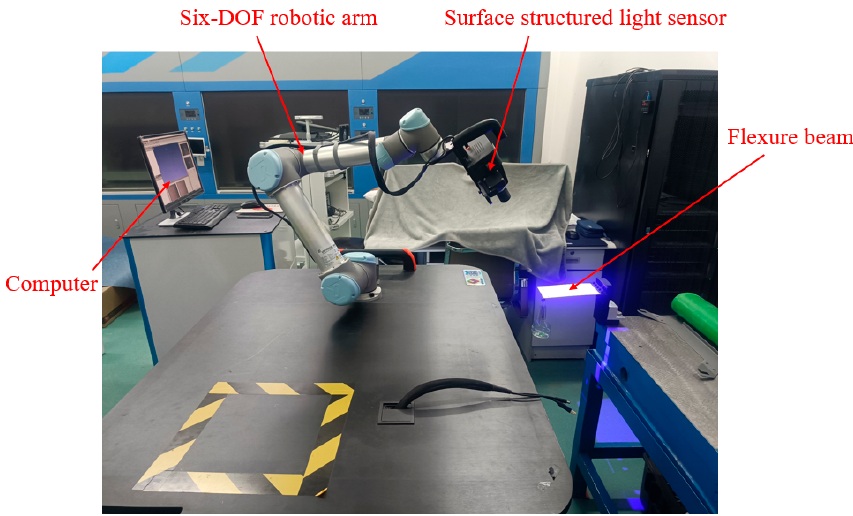
Figure 15. Experimental platform used for the compliance testing of the FLS.